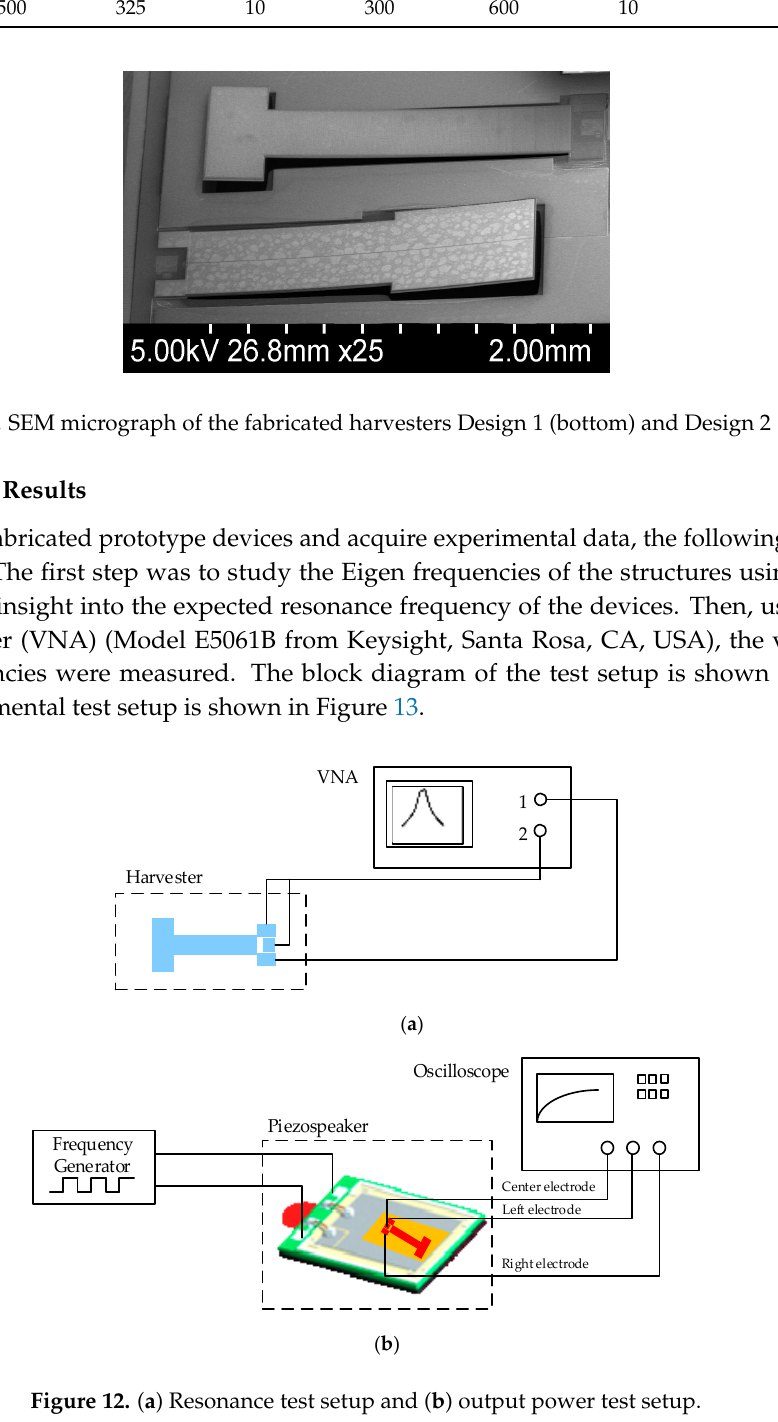
( c ) Figure 13. Photos of ( a ) the experimental test setup; ( b ) the device with the electrical probe tips; and ( c ) the piezospeaker setup with the device under test attached to it. The two designs are such that the mass length is larger than the width in Design 1 while the mass width is larger than the length in Design 2. The average measured resonance frequency of Design 1 is of 4.6 kHz and that of Design 2 is 3.5 kHz. It is worth noting that the fabrication process is responsible for a small variation of the resonant frequencies of the devices from simulations, even after model tuning. As mentioned earlier, Design 2 is interdigitated while Design 1 is not. However, in measurements no significant differences have been noticed, thus electrical tests focused only on Design 1. The output response of Design 1 measured with the VNA is shown in Figure 14, outlining the resonance frequency, bandwidth and the Q-factor. The bandwidth is measured to be about 63.3 Hz with a resonant frequency of 4.6 kHz and quality factor 72.7. The damping ratio is calculated to be ζ = 1/2Q = 0.007.